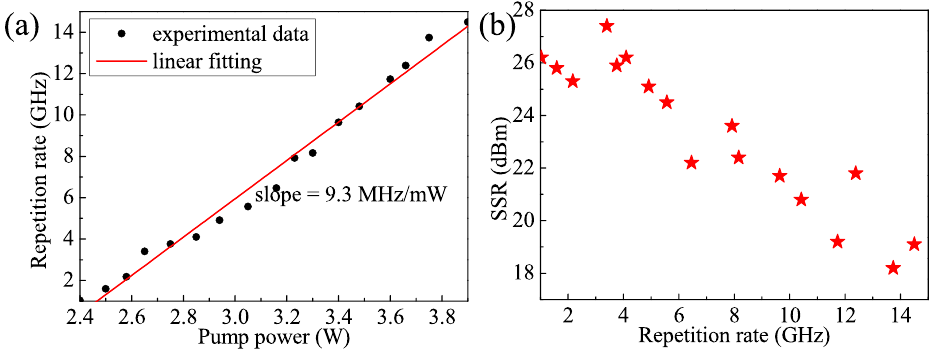
Figure 2. ( a ) Repetition rate of the HML as a function of pump power, and ( b ) SSRs of the HML at different repetition rates.